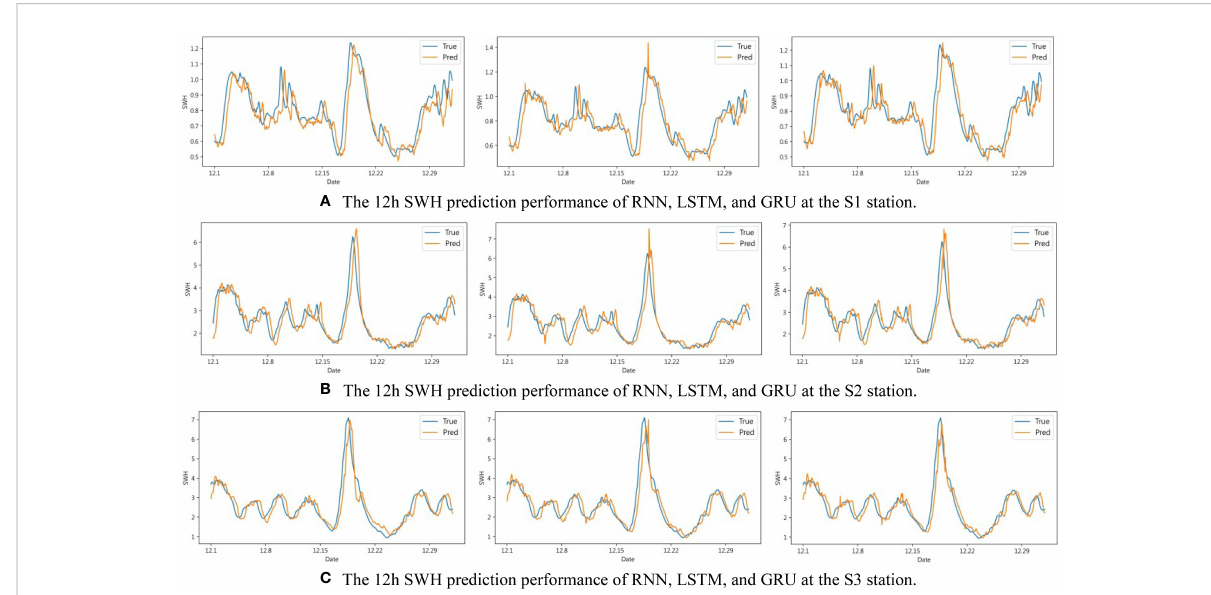
FIGURE 8 12h SWH prediction performance of RNN, LSTM, and GRU at S1, S2, and S3. (A) The 12h SWH prediction performance of RNN, LSTM, and GRU at the S1 station. (B) The 12h SWH prediction performance of RNN, LSTM, and GRU at the S2 station. (C) The 12h SWH prediction performance of RNN, LSTM, and GRU at the S3 station.